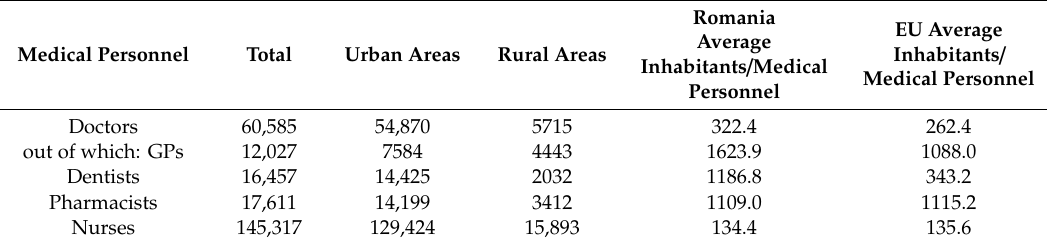
Table 1. Health workforce structure in Romania (2018).